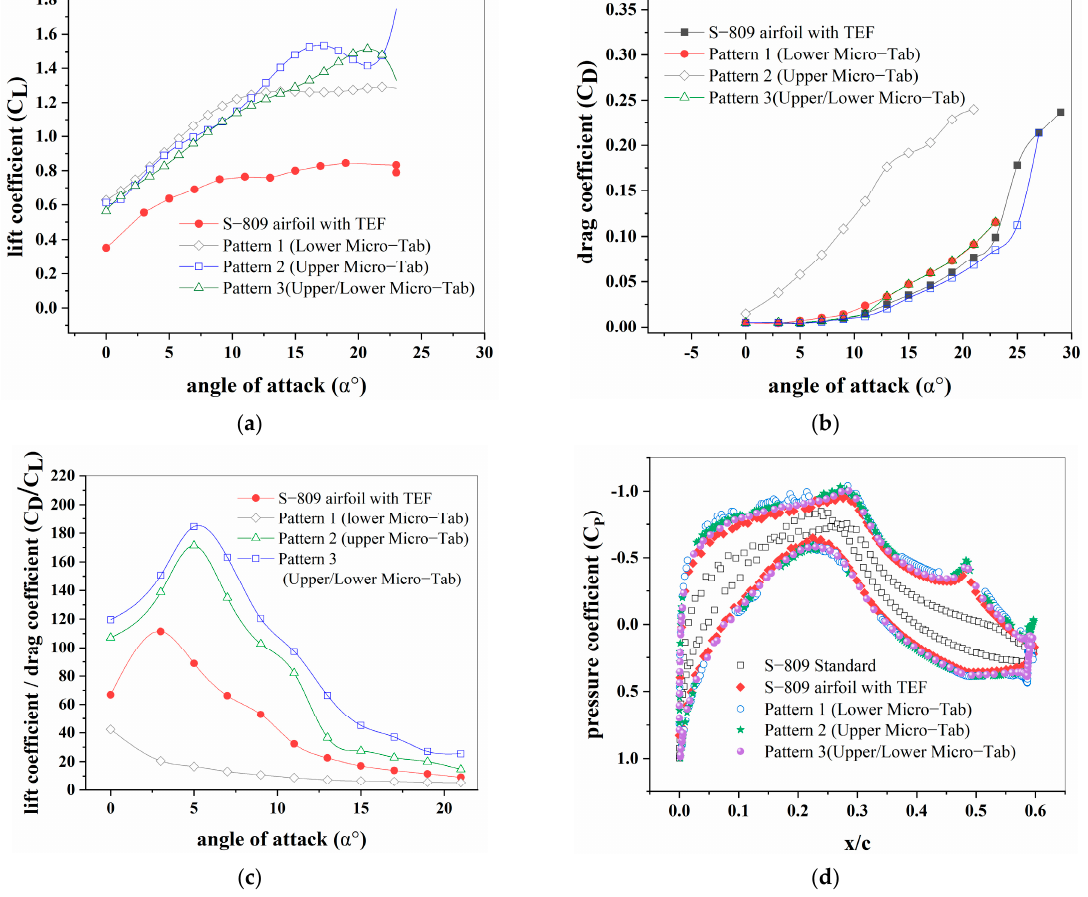
Figure 7. The aerodynamic performance effect of TEF with Micro-Tab: ( a ) comparison of C L ; ( b ) comparison of C D , ( c ) comparison of C L /C D ; ( d ) comparison of C P distribution at α = 0°.